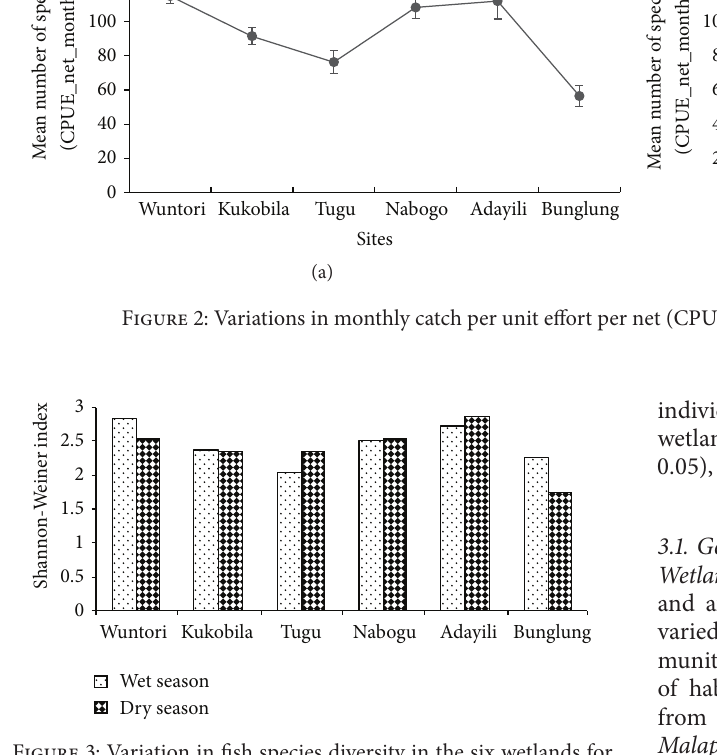
Figure 3: Variation in fish species diversity in the six wetlands for both dry season and wet season.